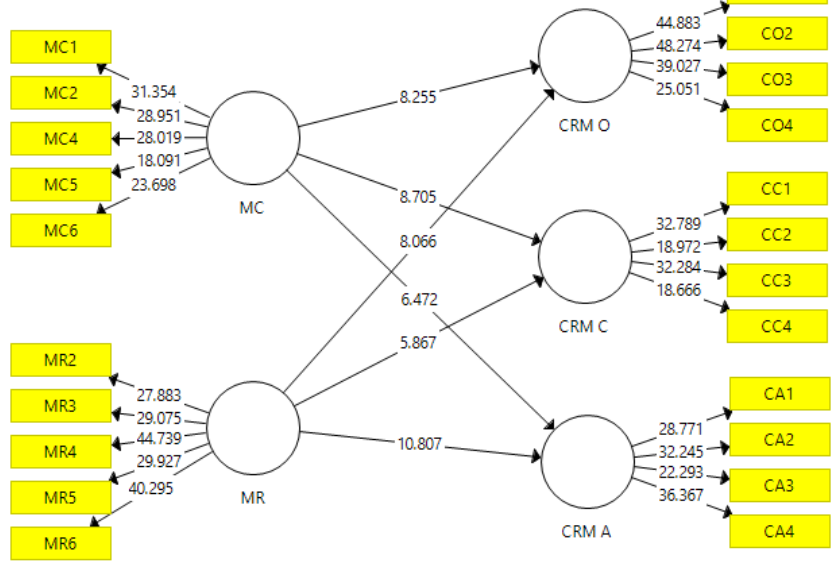
3 Fig. 3. Digital Marketing and Customer Relationship Management Modeling